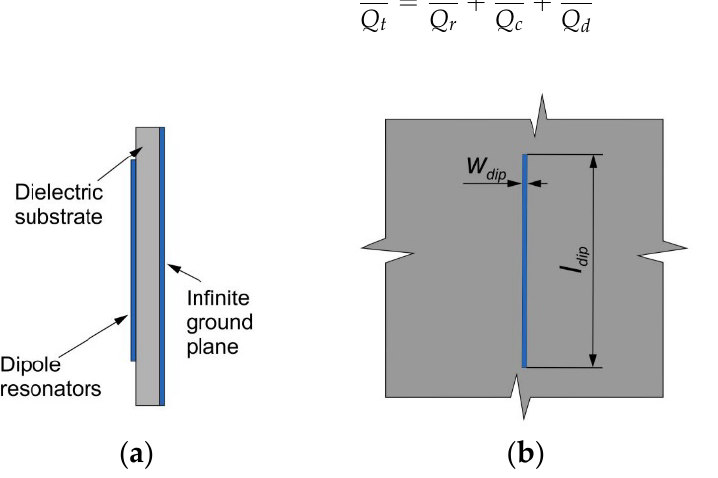
Figure 1. Cross-section ( a ) and top view ( b ) of the dipole placed above an infinite metallic plate.